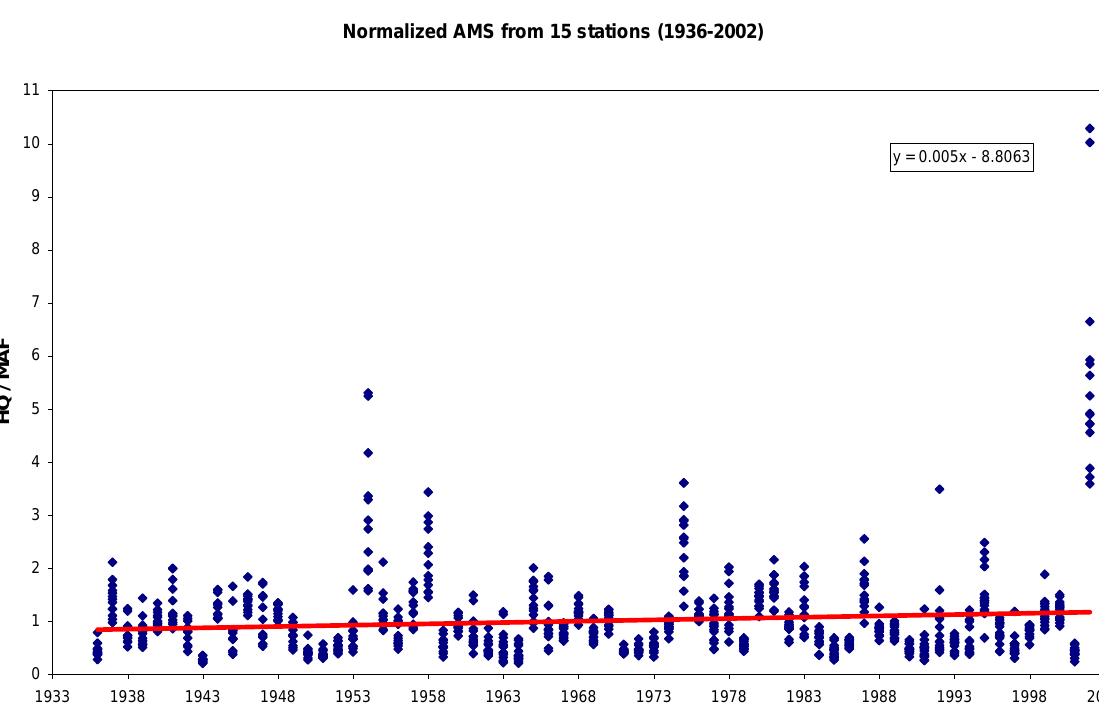
Figure 3: Regional trend test based on discharge data of 15 stations